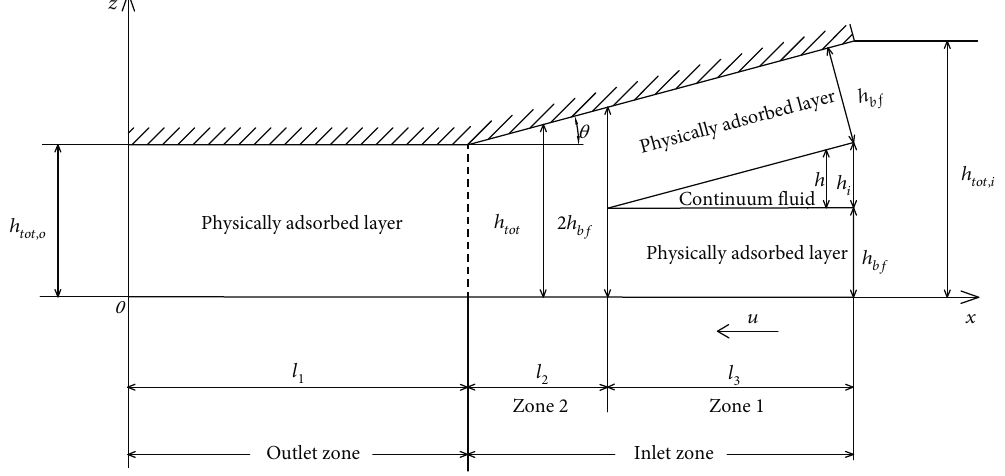
Figure 1: The studied hydrodynamic wedge-platform thrust slider bearing with ultralow surface